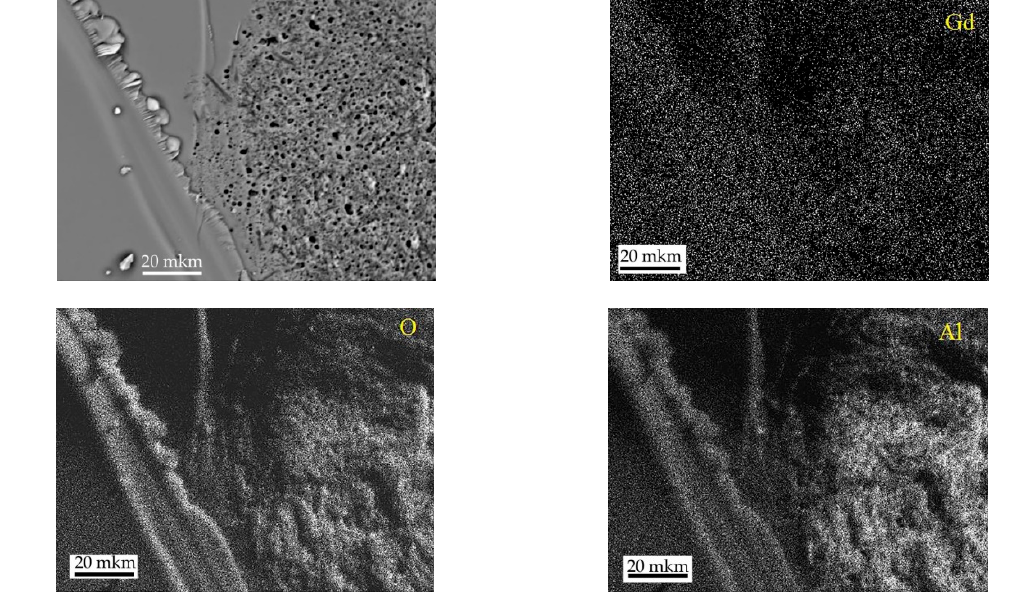
Figure 15. The distribution of chemical elements in the GdAB-based composite.